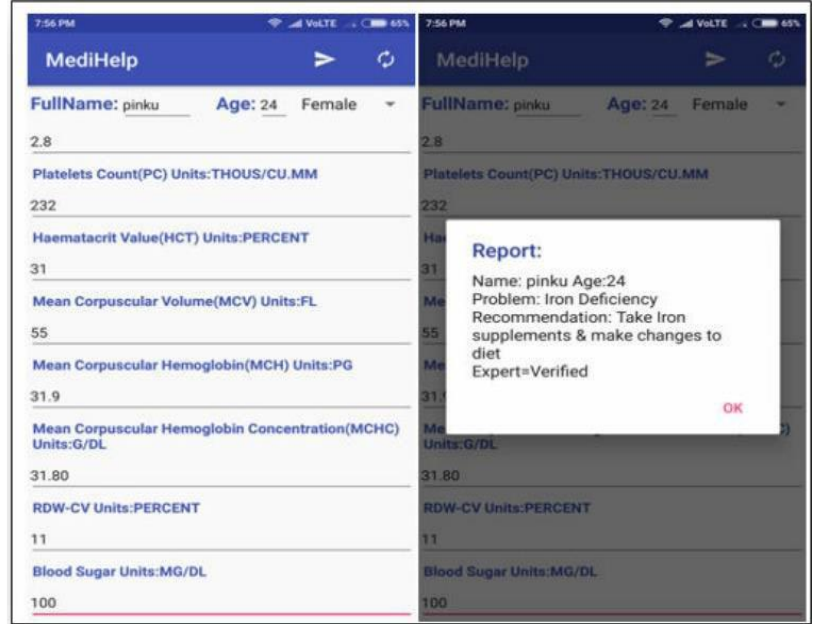
Figure 6. A user interface to fill in the details of user 1.